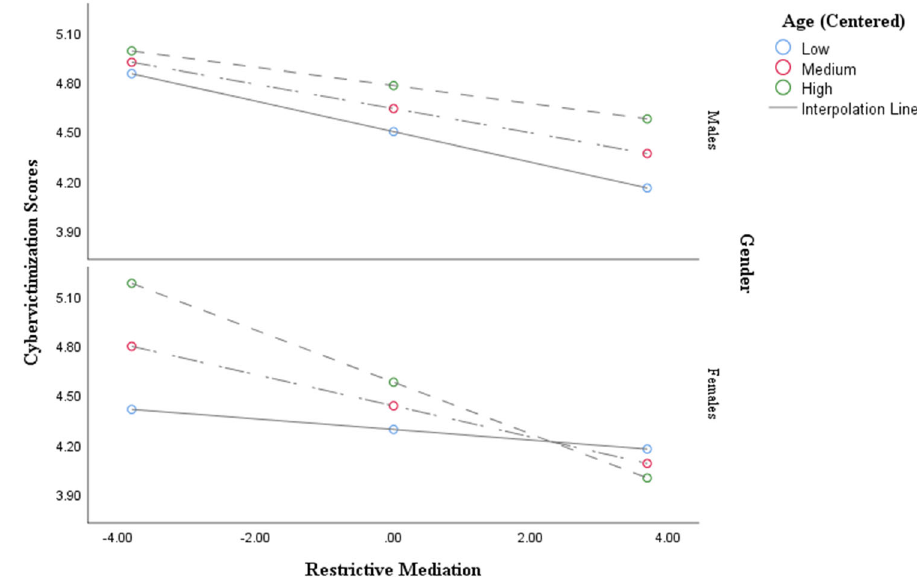
Fig. 4 Graphical representation of three-way interaction between restrictive mediation, age, and